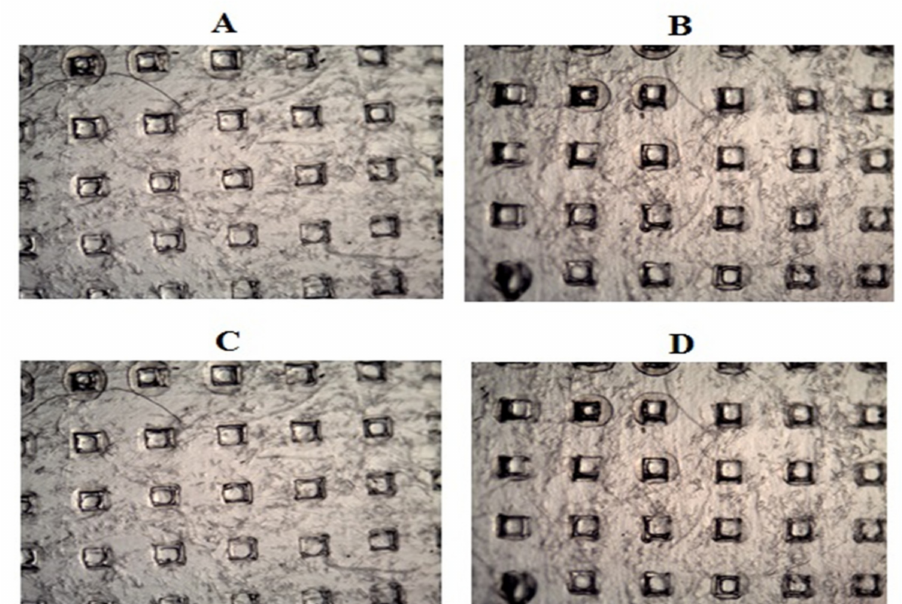
Figure 13. Microscopic image of parafilm-M layers: ( A ) first layer, ( B ) second layer, ( C ) third layer, and ( D ) fourth layer after insertion of LS-TC-MNP-3 in order to study the penetration ability of